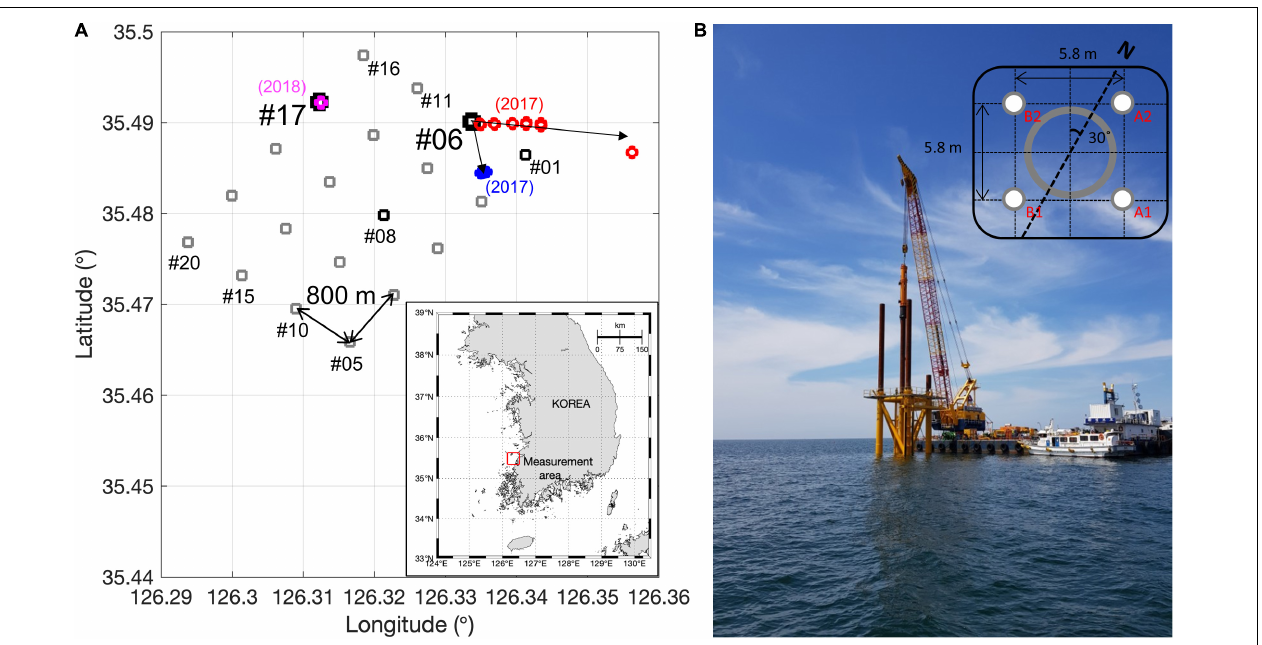
FIGURE 1 | (A) Location of “Southwest offshore wind farm” located on the southwest coast of Korea and layout of twenty offshore wind turbines. Black squares indicate wind turbines that are either completed or under construction and gray squares indicate the expected locations for wind turbine installation. Circles represent measurement points. (B) Photograph of wind turbine construction. (Inset) Schematic diagram of wind turbine 6 consisting of four piles (A1, A2, B1, and B2).